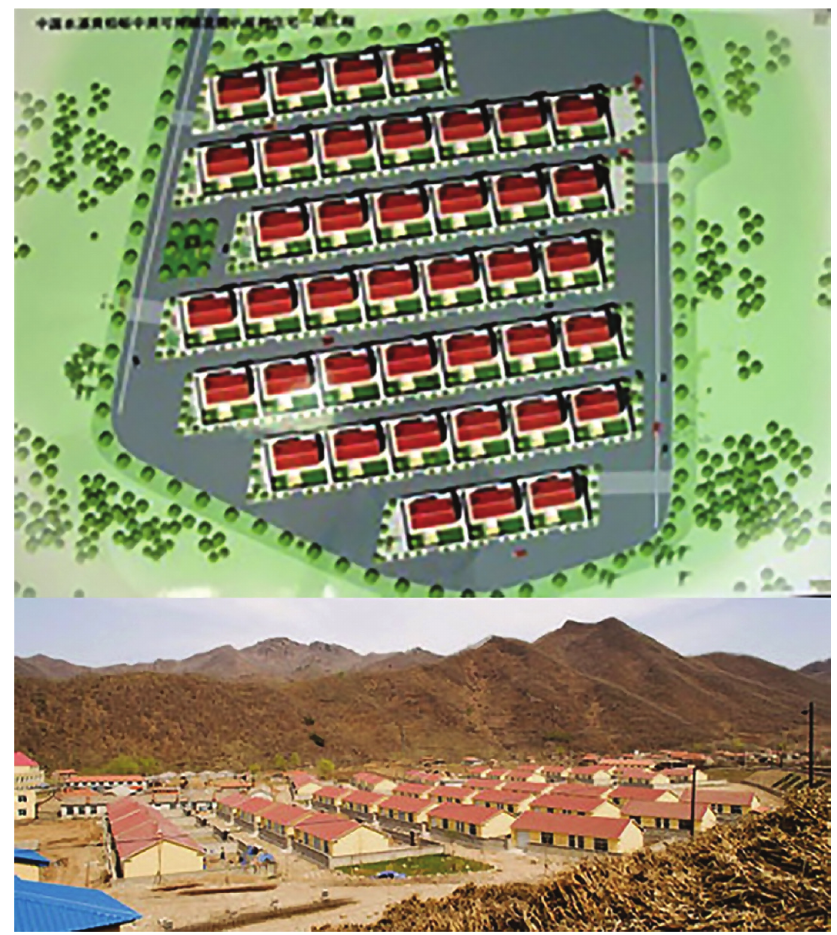
Figure 2. Huangbaiyu Cradle-to-Cradle Eco-Village, China (2004): Site plan and bird’s eye view after the completion of the first phase. Disregarding existing commu- nities, its infrastructures and modes of production, this bio-deterministic project pro- duced a decontextualized piece of architecture, out of touch with the real “nature” of the site © Shannon